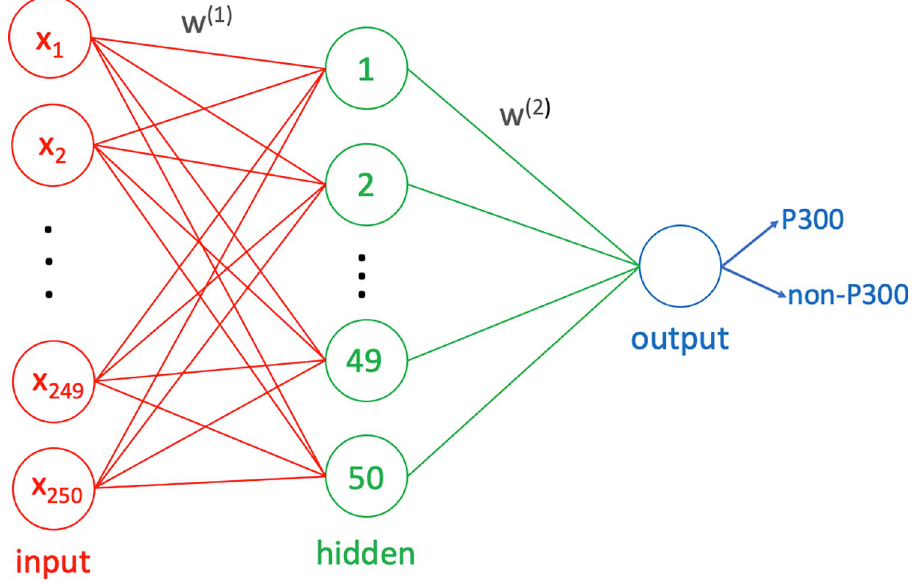
Fig 10. Two-layer artificial neural network